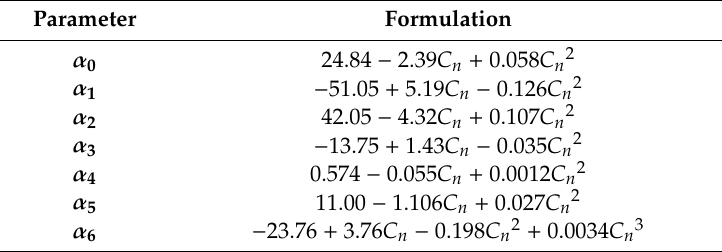
Table 2. Calibrated coefficients of Equation (1).